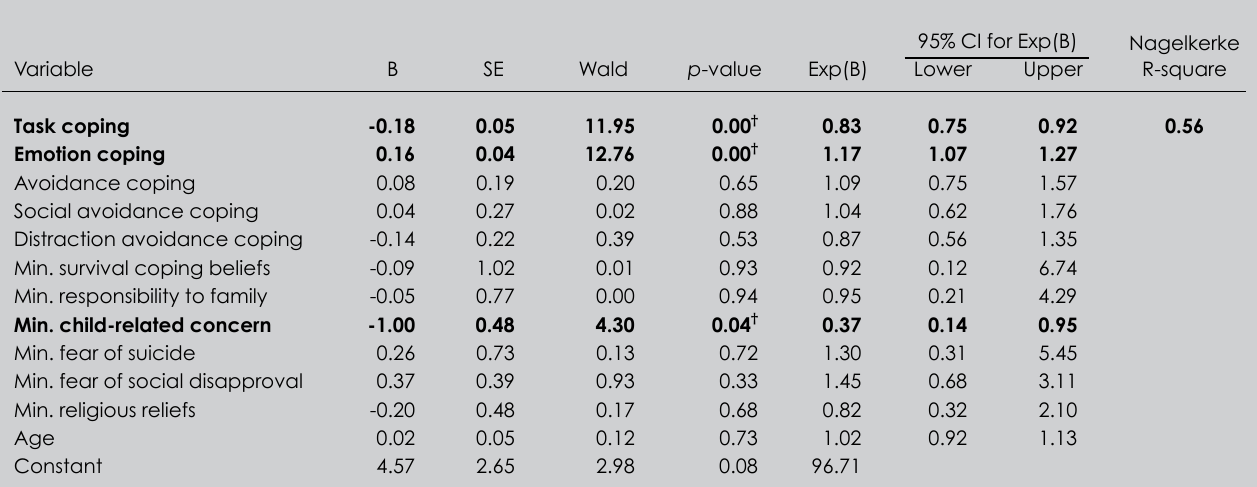
Table VII. Association between coping skills, reasons for living and